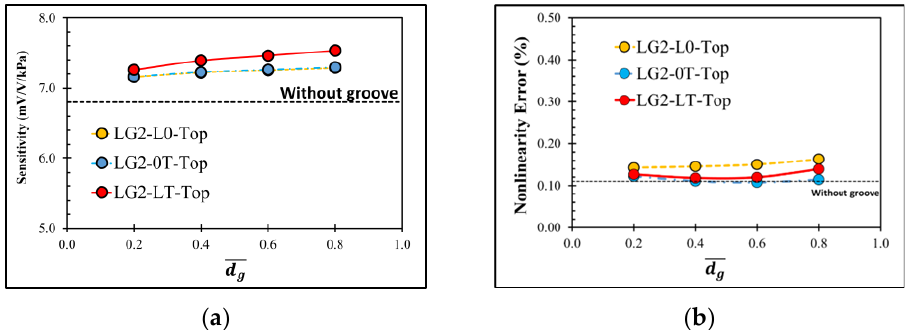
Figure 11. Variations of ( a ) sensitivity and ( b ) nonlinearity error with dimensionless groove depth of sensor with local grove 𝐿𝐺2 on the top of diaphragm at 𝑙 𝑔 ̅ = 0.175 .